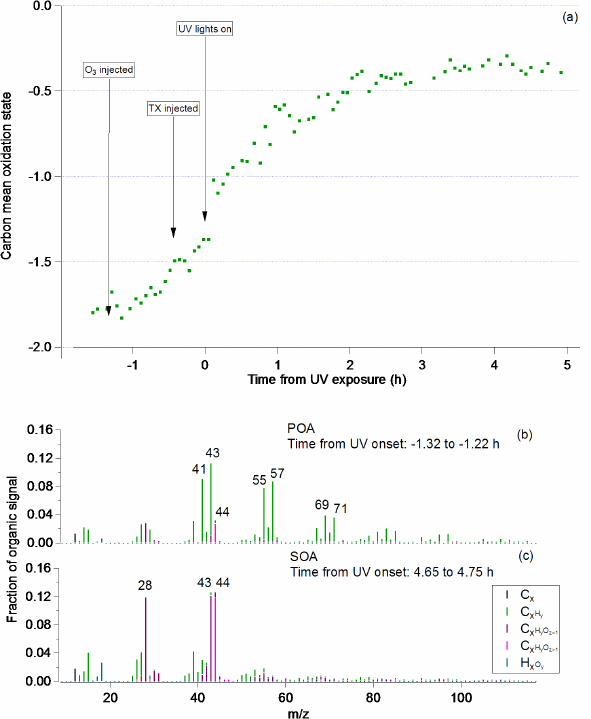
Figure 2. Evolution of the carbon mean oxidation state of the or- ganic material coating the diesel soot (a) (carbon mean oxidation state ≈ 2 O/C–H/C; Kroll et al., 2011), during DEP2. Also shown are the high-resolution mass spectra for the POA (b) and SOA (c) , ∼ 1h before and ∼ 5h after the onset of UV exposure respectively. The characteristic for urban POA is the high amount of hydrocar- bons, especially m/z 43 and 57. More oxygenated species, where m/z 44 is dominating over m/z 43, are typical for more rural SOA. Also, the latter show a higher carbon mean oxidation state than the former.